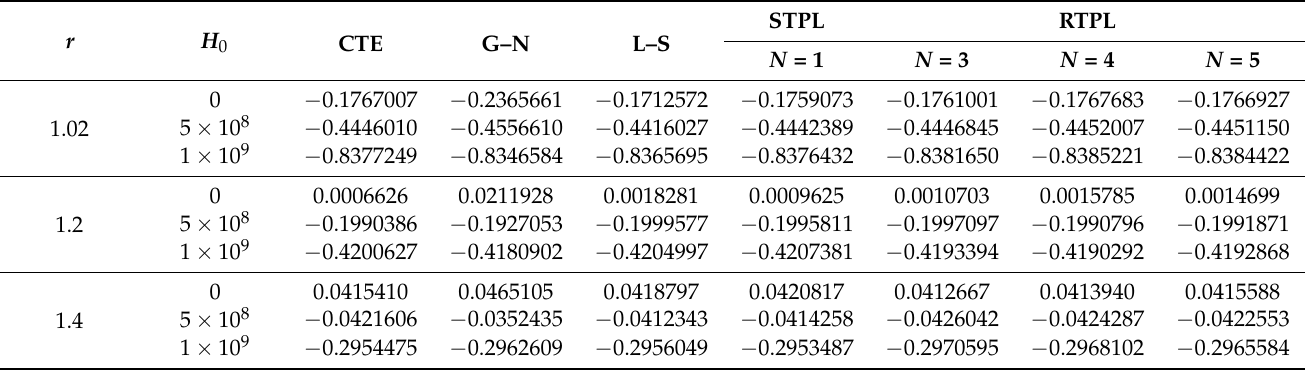
Table 7. Different thermoelasticity theories with a range of r values show the effects of dimensionless magnetic field intensity H 0 on radial displacement u